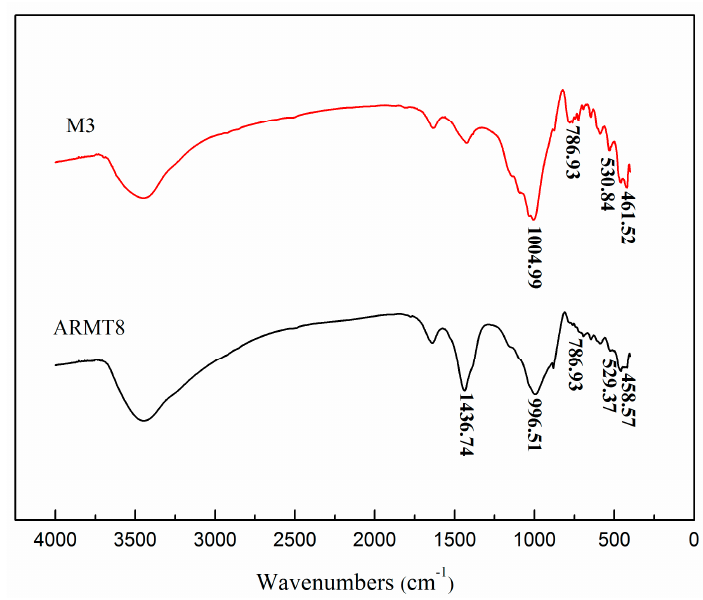
Figure 16. FTIR spectra of the samples M3 (Table 2) (after 3 h of activation) and ARMT8 (Table 3).